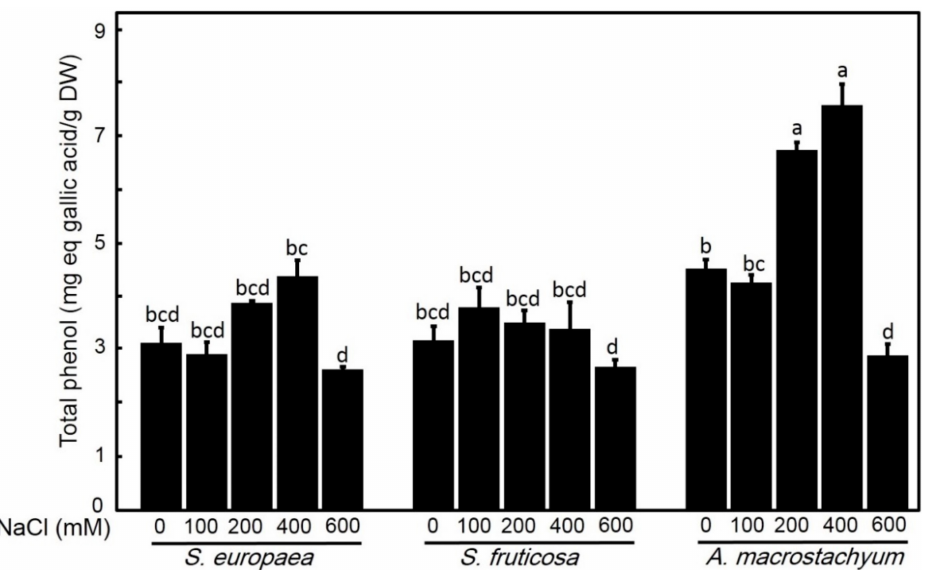
Figure 9. Total phenol contents of S. europaea, S. fruticosa and A. macrostachyum under different NaCl concentrations. Mean ± SE of three replicates. Different letters indicate significant differences ( p < 0.05).